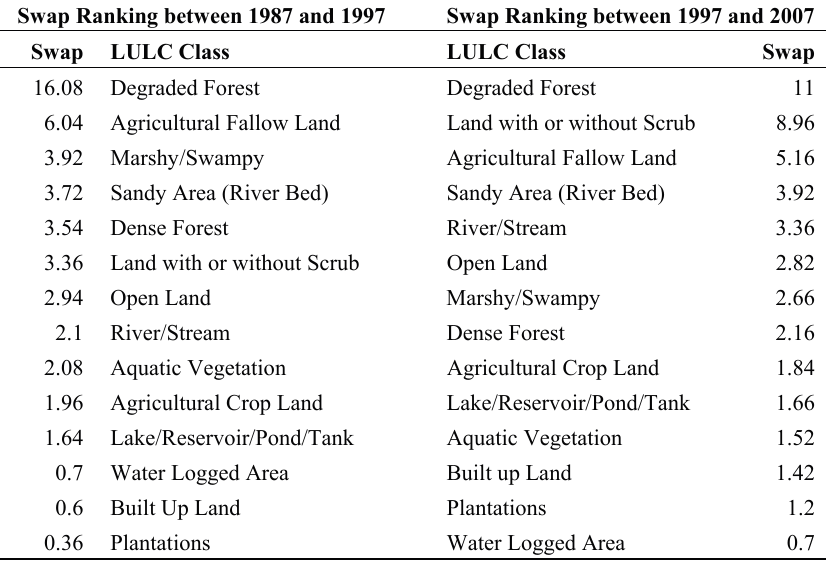
Table 13. Ranking of swap rate between different time